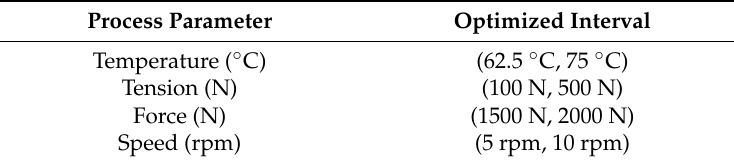
Table 7. Process parameters interval